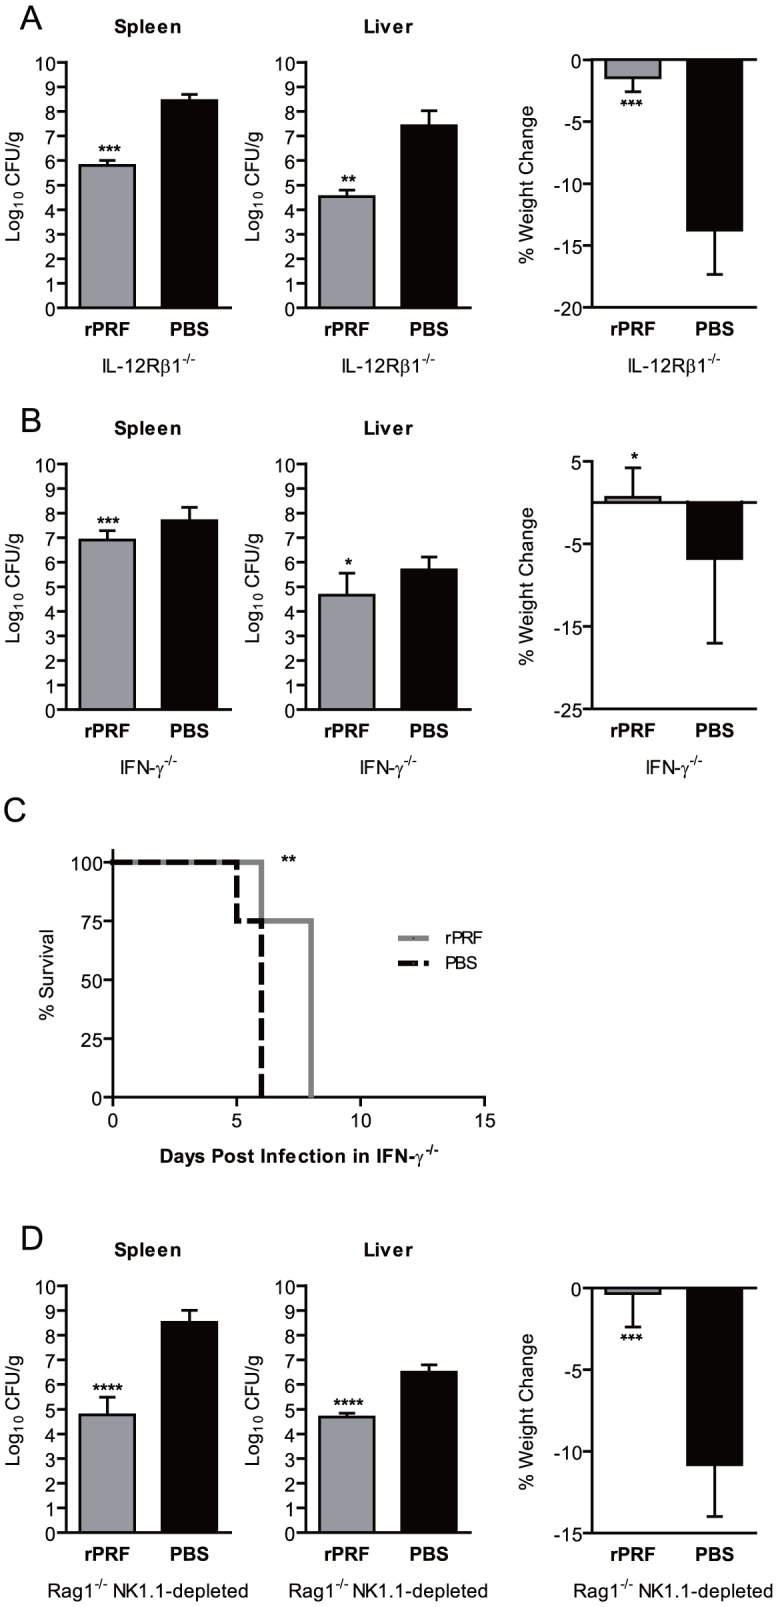

T. gondii profilin induced protection against L. monocytogenes is independent of IL-12 and T and NK cells, but dependent on IFN-γ.(A) IL-12Rβ1 deficient (IL-12Rβ1−/−) mice (n = 4–5/group) were stimulated i.v. with 100 ng rPRF (grey) or PBS (black) 4 hours prior infection with ∼1×104 CFU of L. monocytogenes. At 72 hours post L. monocytogenes infection, bacterial burdens of the spleen and liver, and percent weight change as compared to immediately prior to infection were quantified. Data shown are the mean ± SD from one of four independent experiments. (B) IFN-γ deficient (IFN-γ −/−) mice were stimulated i.v. with 100 ng rPRF (grey) or PBS (black) 4 or 24 hours prior to infection with ∼200 CFU of L. monocytogenes. Bacterial burdens of the spleen and liver, and percent weight change as compared to immediately prior to infection were quantified after 72 hours. Data shown are the mean ± SD from three experiments (each n = 3–7/group). (C) Survival of IFN-γ −/− mice (n = 6/group) stimulated with 100 ng rPRF (grey) or PBS (black) 4 hours prior to infection with ∼200 CFU of L. monocytogenes. (D) Rag1 deficient (Rag1−/−) mice depleted with anti-NK1.1 MAb PK136 (n = 4/group) were stimulated i.v. with 100 ng rPRF (grey) or PBS (black) 4 hours prior infection with ∼8×104 CFU of L. monocytogenes. At 72 hours post L. monocytogenes infection, bacterial burdens of the spleen and liver, and percent weight change as compared to immediately prior to infection were quantified. Data shown are the mean ± SD from one of two independent experiments. (A–D) * indicates p<0.05, ** indicates p<0.01, *** indicates p<0.001, and **** indicates p<0.0001.